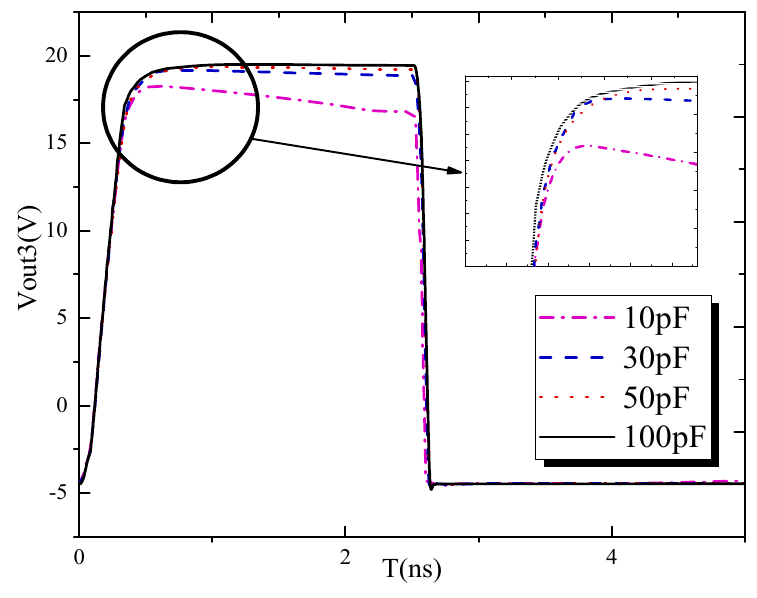
Figure 8. V OUT3 with different C B values.